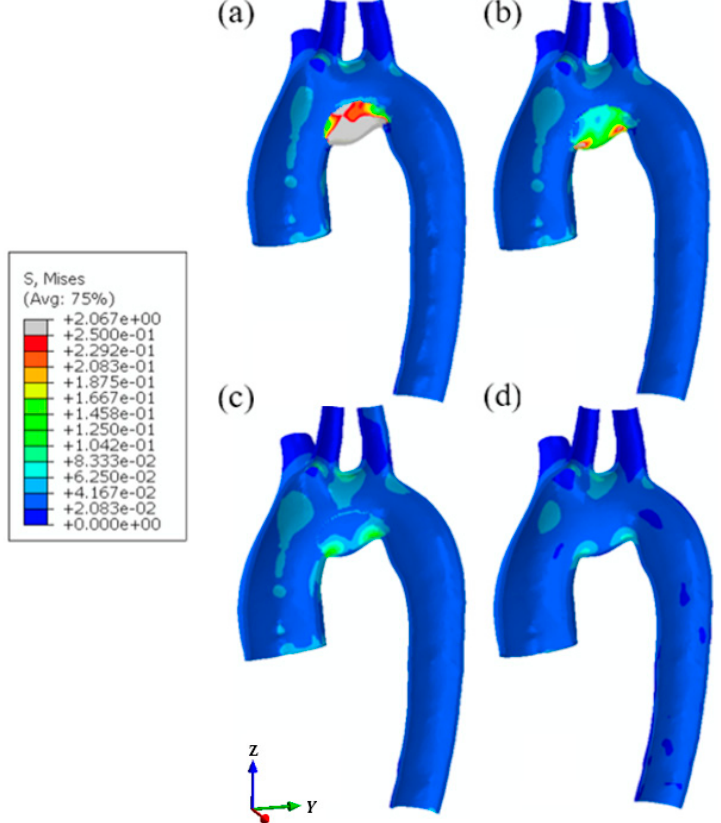
Figure 9. Stress distributions at t = 0.4 s (peak systolic pressure): ( a ) PTFE graft = 1000 MPa, ( b ) Cormatrix graft = 30 MPa, ( c ) pulmonary graft = 3 MPa, and ( d ) native tissue equivalent graft = 0.84 MPa.